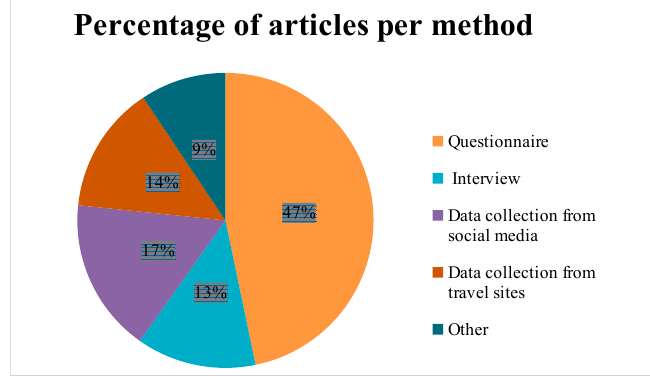
Figure 5. Percentage of articles per method.